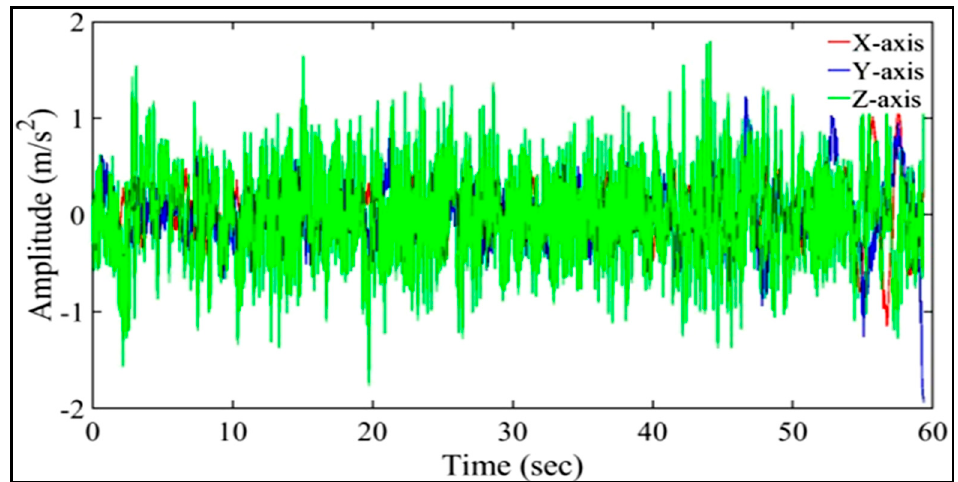
Figure 2. Time domain response along the translational axes.